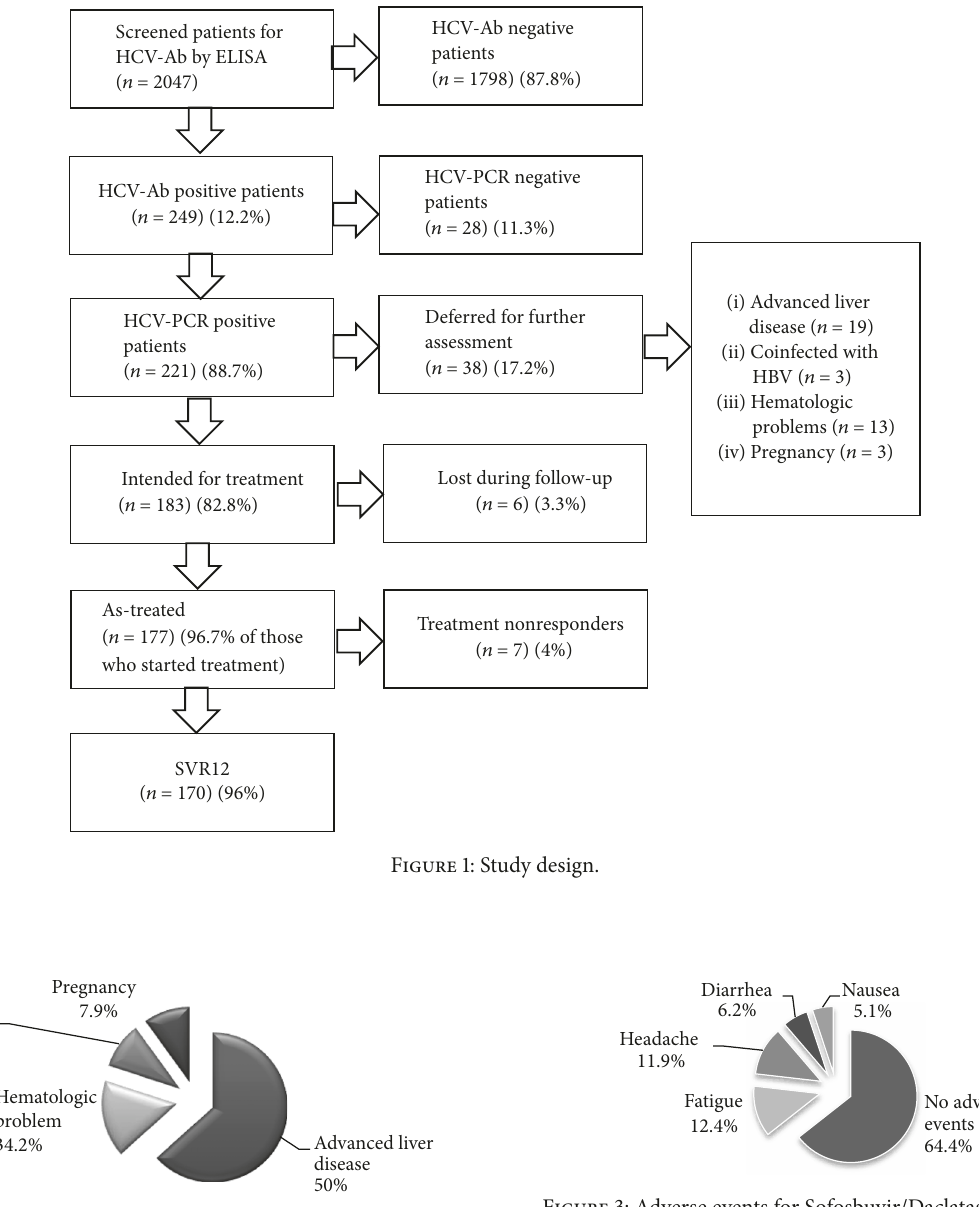
Figure 2: Analysis of causes of deferral from the current study.